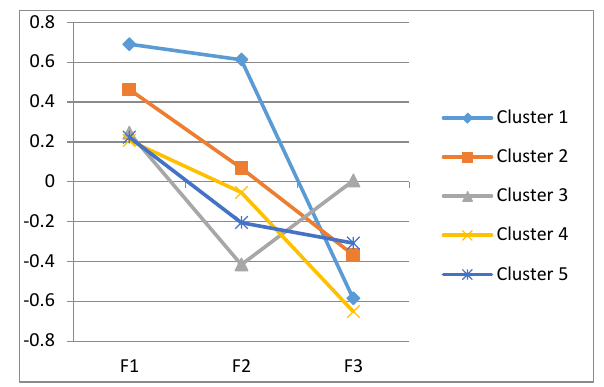
Fig. 1. Graph of average values of